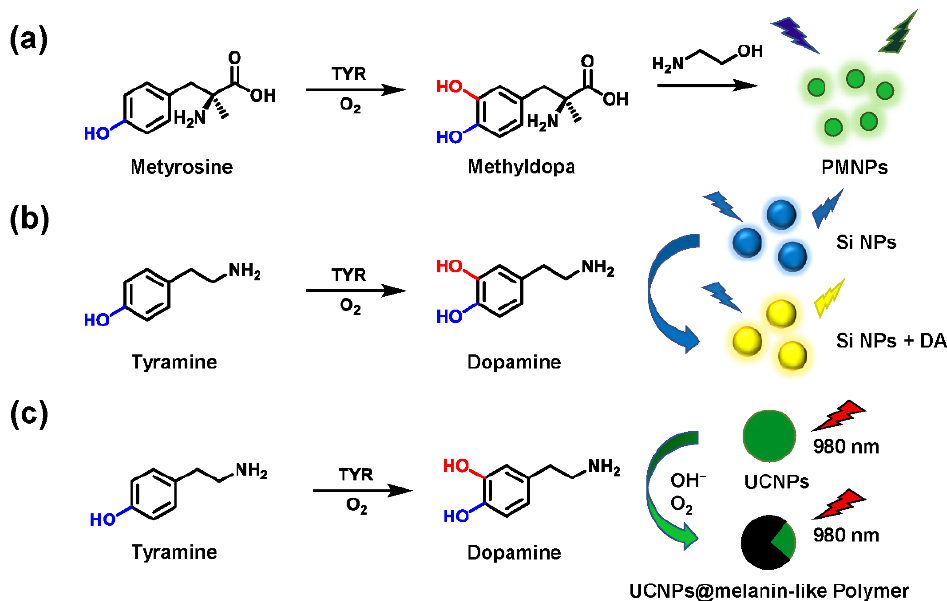
Figure 11. Schematic illustration of the PMNPs ( a ), Si NPs ( b ), and UCNPs ( c ) for the TYR activity detection.